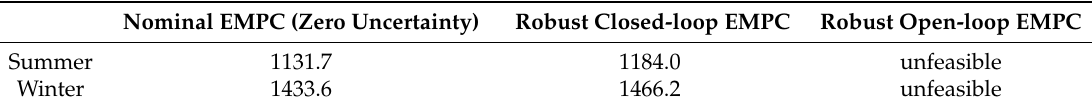
Table 3. Daily economic costs.